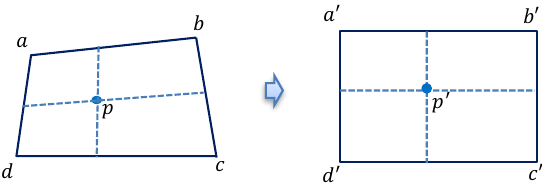
Figure 7. Bilinear interpolation method for calibrating image distortion.